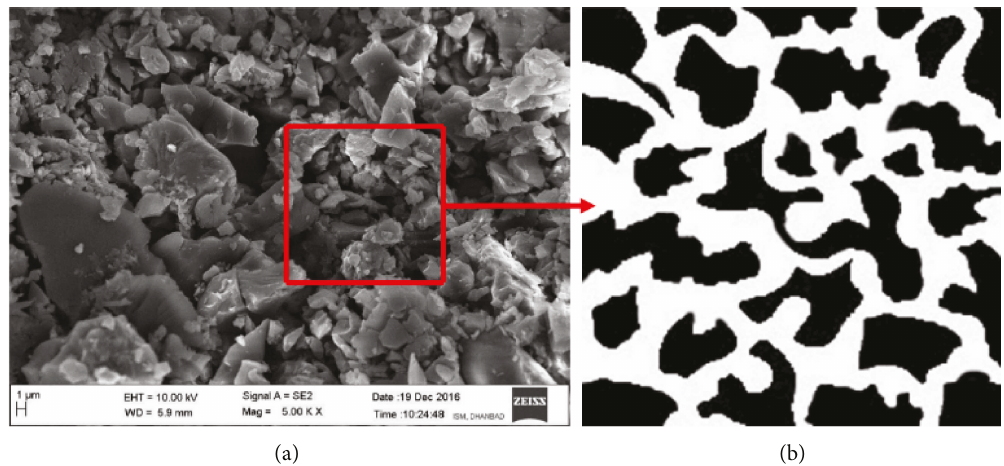
Figure 7: (a) The SEM image of a coal sample (reproduced from Figure 1 in [31]). (b) The reconstructed heterogeneous porous media with fractures (white) and organic matrix (dark) for simulation.